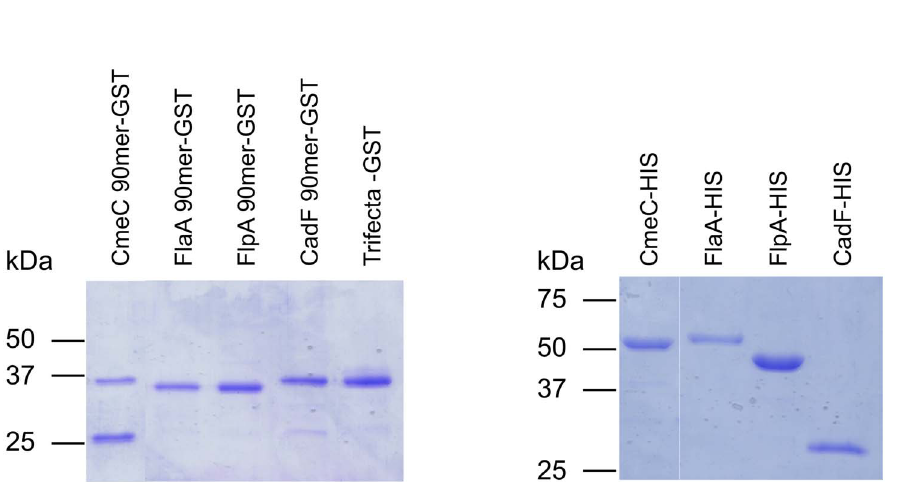
Figure 2. Purified GST- and 6X His-tagged proteins. Purified protein extracts were separated in SDS– 12.5% polyacrylamide gels and stained with Coomassie Brilliant Blue R-250. The molecular mass of the protein standards are listed in